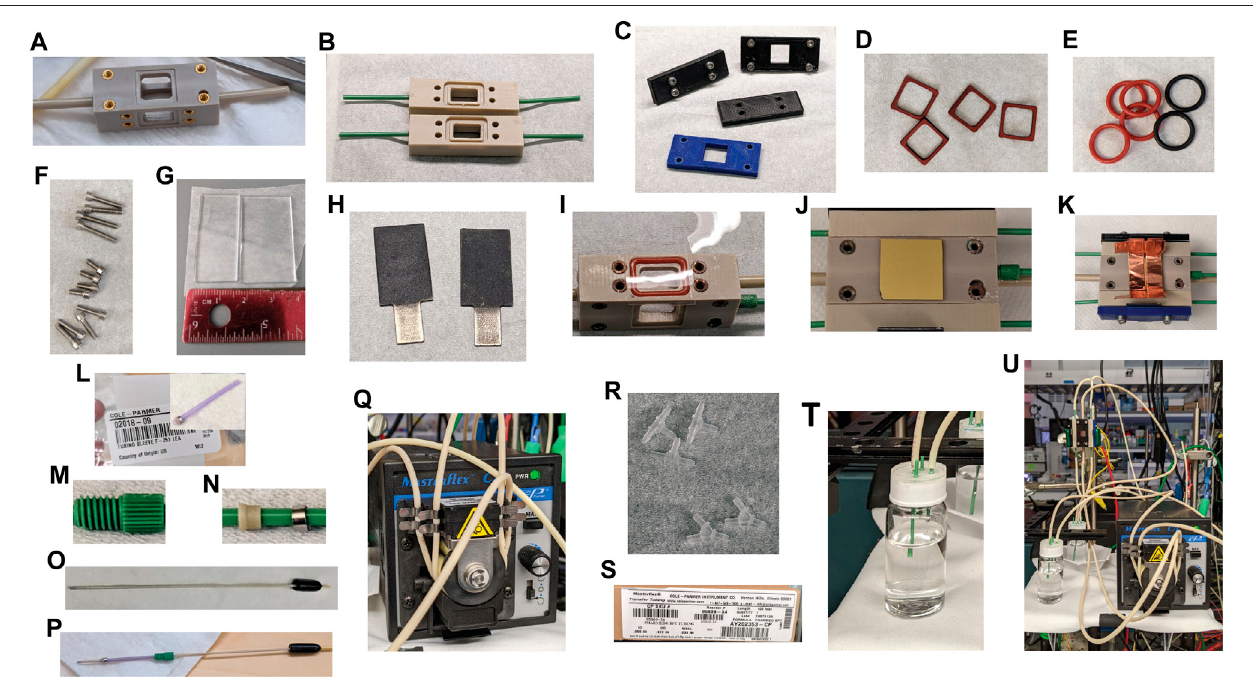
FIGURE 5 | Components of the testing vessel. (A) PEEK cathode compartment. (B) PEEK anode compartments. (C) 3D-printed PLA compression plates. (D) Laser-cut silicone gaskets. (E) Size 013 silicone and Viton O-rings. (F) 2 – 56 stainless steel screws. (G) Quartz glass window. (H) Iridium oxide anodes with integrated electrical connection. (I) Na fi on 115 cut to fi t. (J) 1.1 cm square photocathode with a back ohmic contact. (K) An electrical connection, like copper tape, to the photocathode. (L) F-252 tubing sleeve for the reference electrode. (M) IDEX M-644-03X fl angeless nut. (N) IDEX M-650X ferrules. (O) LF-1 Ag/AgCl reference electrode. (P) Completereference electrode assembly. (Q) Master fl experistaltic pump. (R) 1/16 ″ PVDF barbed “ Y ” or “ T ” fi ttings. (S) 1.42 mm ID PharMed BPT tubing. (T) Electrolyte reservoirs. (U) Assembled cell, pump, and